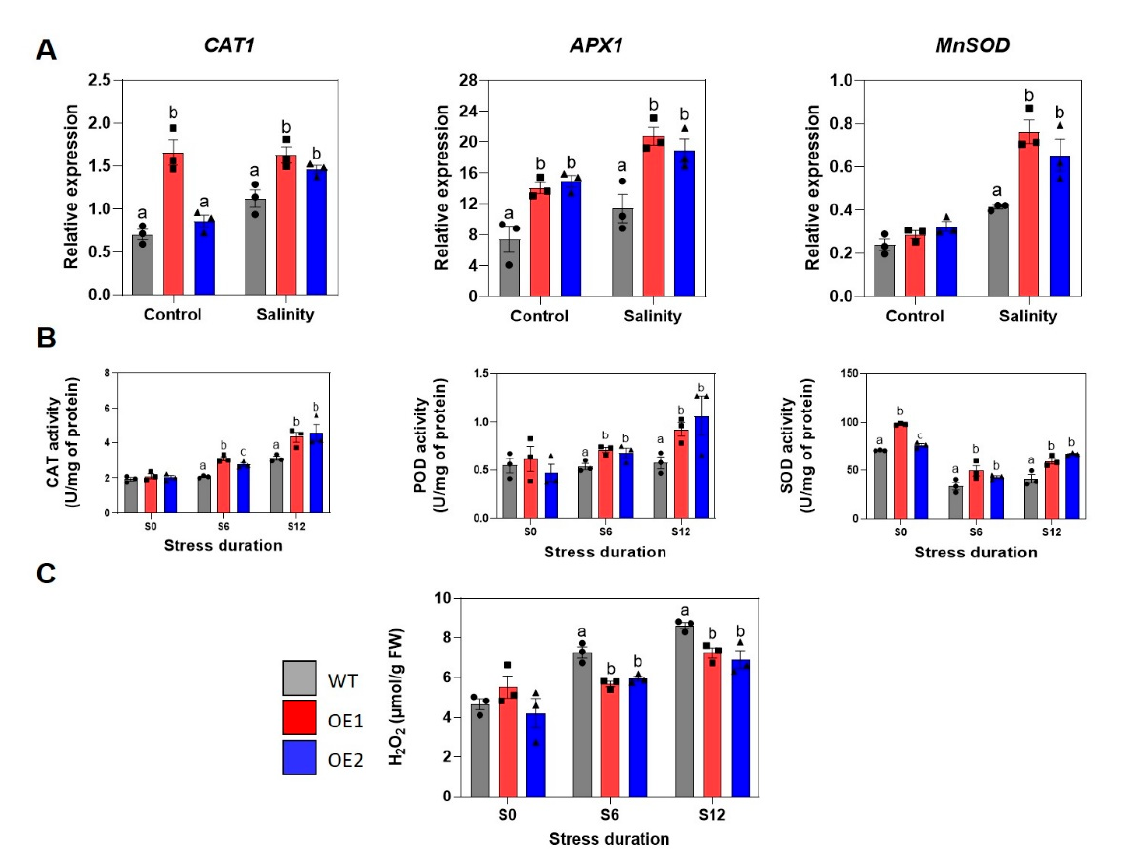
Figure 4. Evaluation of components of the reactive oxygen species-scavenging system in transgenic (OE1 and OE2) and wild-type (WT) plants under control and salinity conditions (S6 and S12 for 6-day and 12-day treatments, respectively). ( A ) Expression profile of antioxidant enzyme-encoding genes. ( B ) Enzymatic activities of catalase (CAT), peroxidase (POD) and superoxide dismutase (SOD). ( C ) Endogenous hydrogen peroxide (H 2 O 2 ) content. Each value represents the mean ± SE ( n = 3). Significant differences among the genotypes in each treatment that were analyzed by ANOVA and Tukey’s honestly significant difference test were indicated by different letters ( p < 0.05).